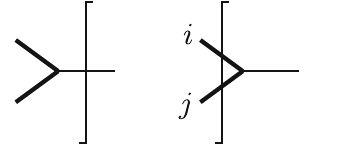
Fig. 9 Massless scalar one-loop three-point function. Thick internal lines denote the insertion of the infinitesimal mass μ , which generates μ -massive propagators